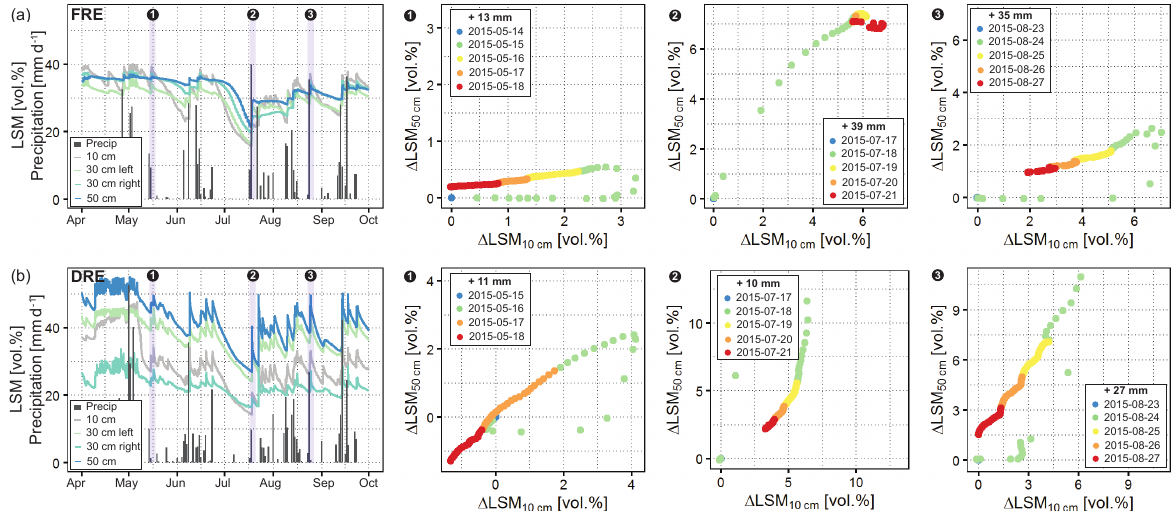
Figure 11. Moisture orbit at FRE (a) and DRE (b) for three precipitation events in 2015. The LSM values are hourly means and expressed as the change of absolute value compared to the first measurement (first day at 23:00). The daily precipitation sums recorded at the beginning of each event are